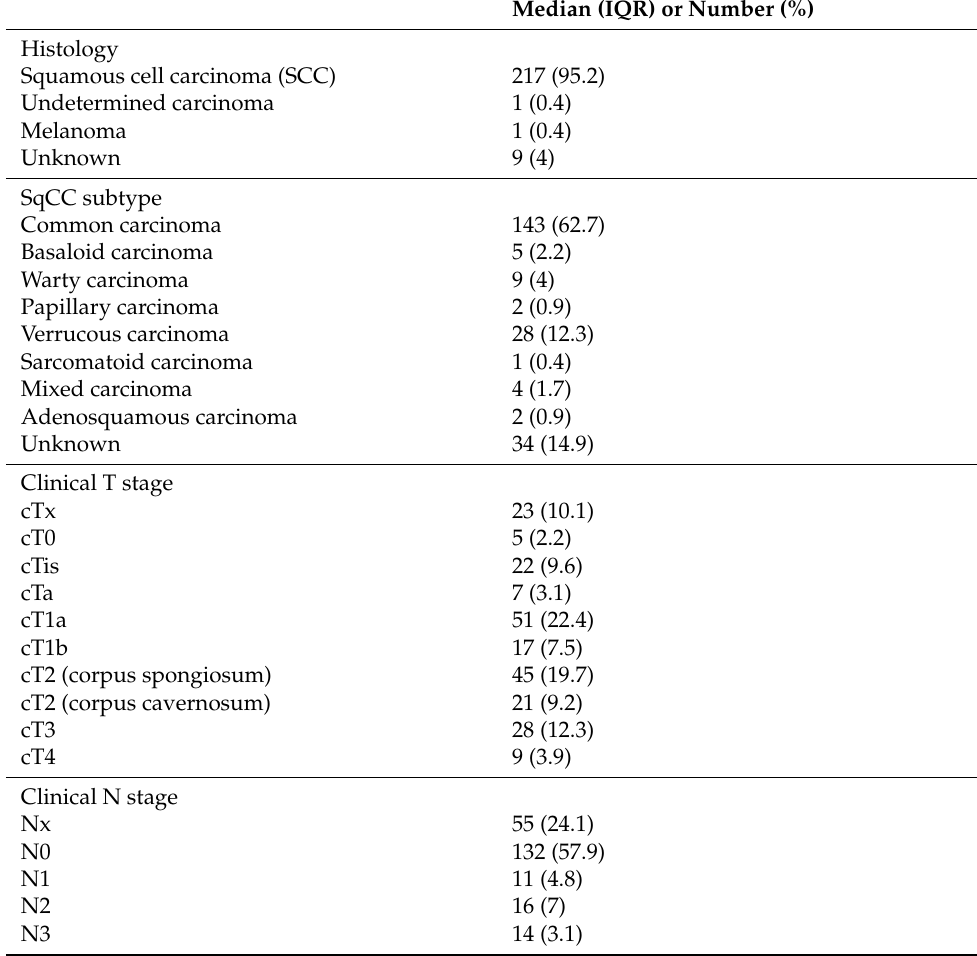
Table 2. Staging and Pathological Features of Penile Cancer ( n =